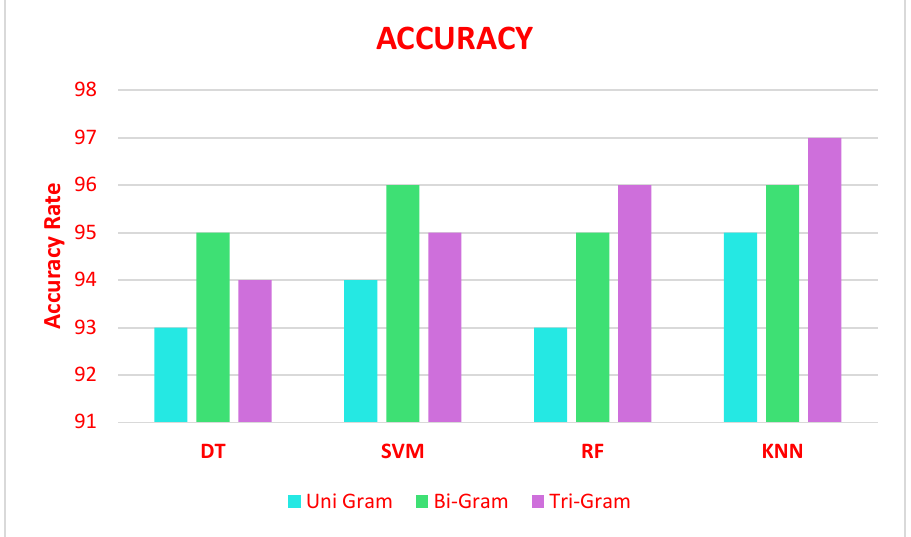
Figure 4. Accuracy of ensemble models (DT, SVM, RF, and KNN) in predicting COVID-19 severity with N-gram stacked autoencoders.